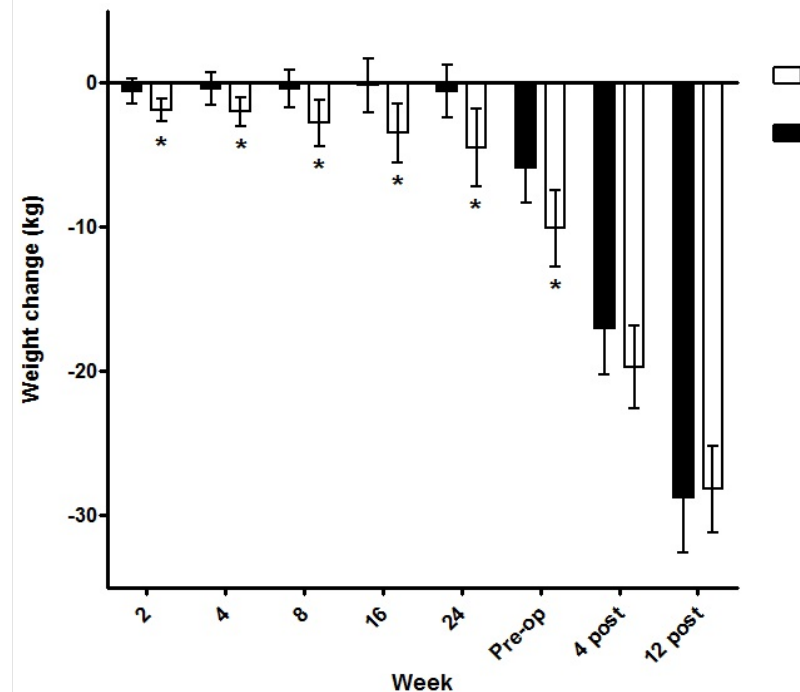
Figure 2. Changes in body weight after intragastric injections. Lines represent mean body weight change over time for each treatment group. * Statistically different means versus control group. Ab-